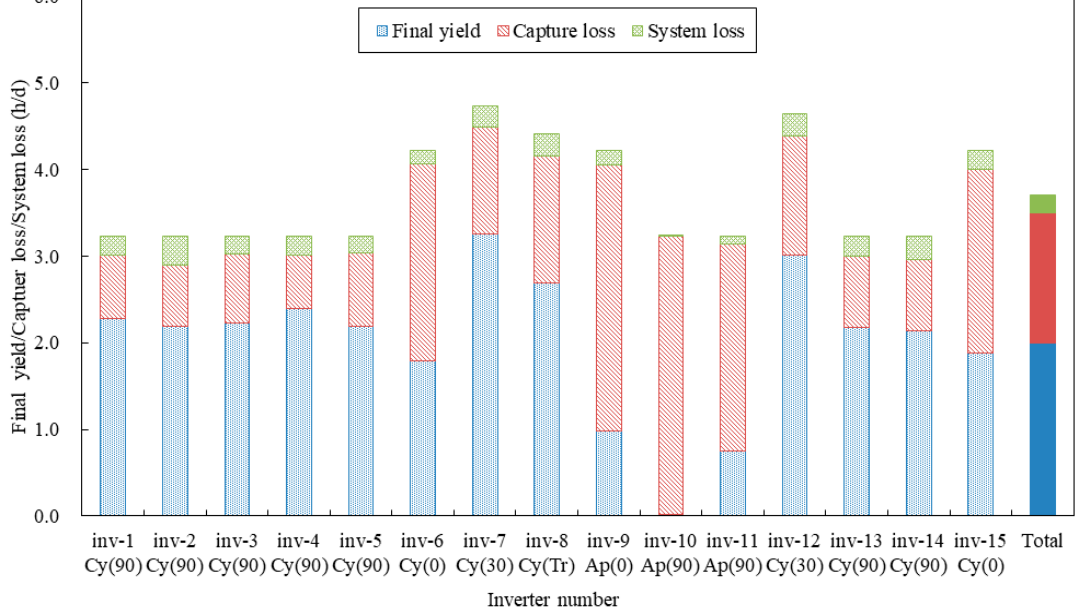
Figure 8. Five-year average final yields, capture losses, and system losses for different inverters.